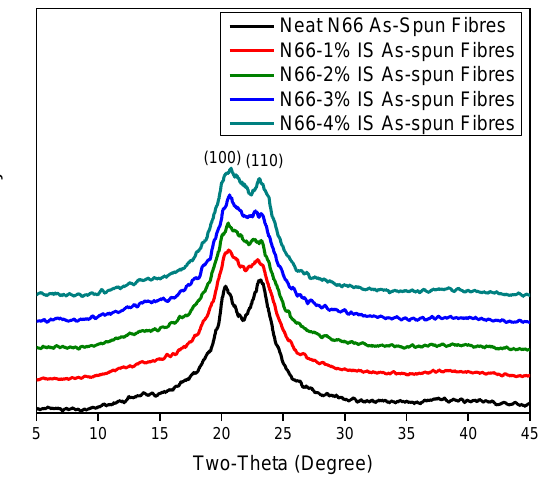
Figure 4. XRD pattern of neat and different salt-confined nylon 6,6 fibres.